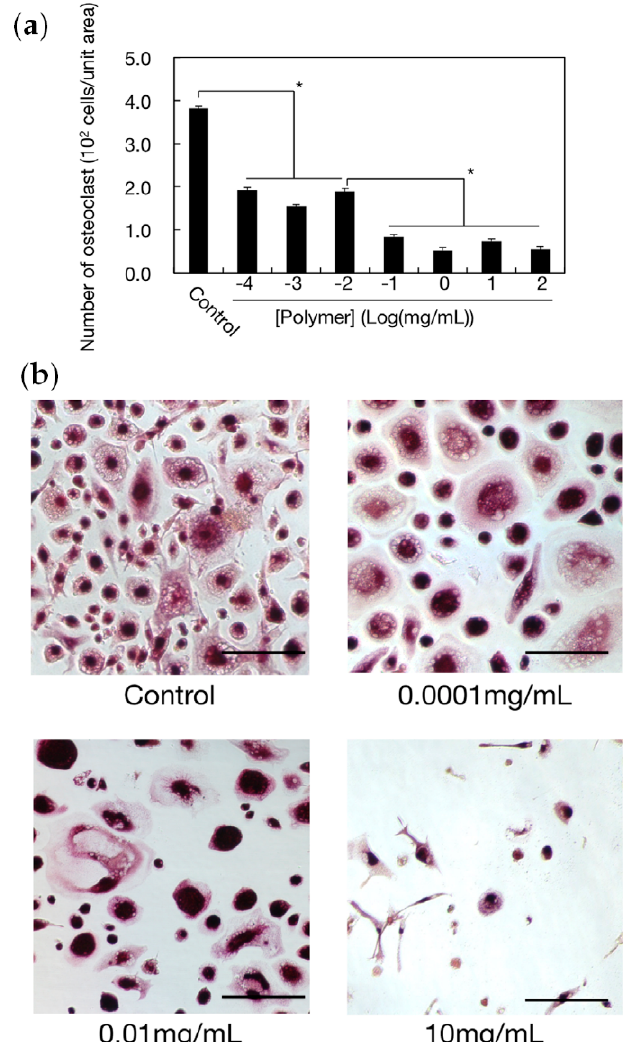
Figure 11. ( a ) Densities of adherent osteoclasts on bovine bone slices after incubation with Na-PEP for 24 h (* p < 0.005); ( b ) Optical micrographs of adherent osteoclasts on a bovine bone slice after cultivation with Na-PEP for 24 h. Scale bars represent 100 µ m. Reprinted with permission from [99]. Copyright (2015) Wiley-VCH Verlag GmbH &